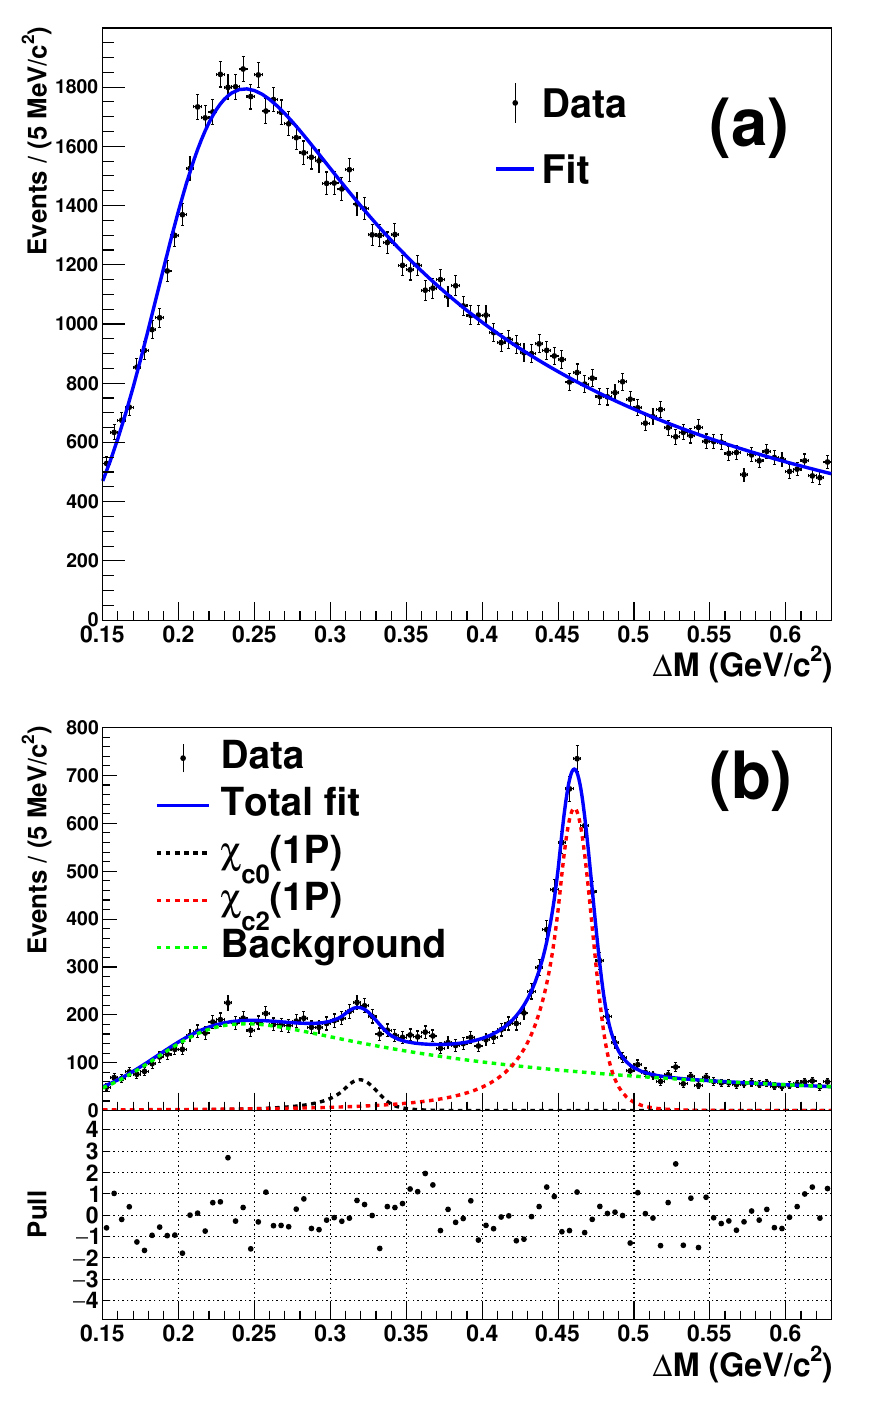
Figure 3 . Mass difference distribution for (a) J/ψ sideband events and (b) J/ψ signal candidates combined with e + e − and µ + µ − pairs. The solid blue curves and the black points with error bars show the overall fit result and the data, respectively. The dotted black, red and green curves show the χ c 0 (1 P ) , χ c 2 (1 P ) and background components in (b), respectively. The pull plot in (b) shows the residual between the overall fit result and the data divided by the uncertainty in each